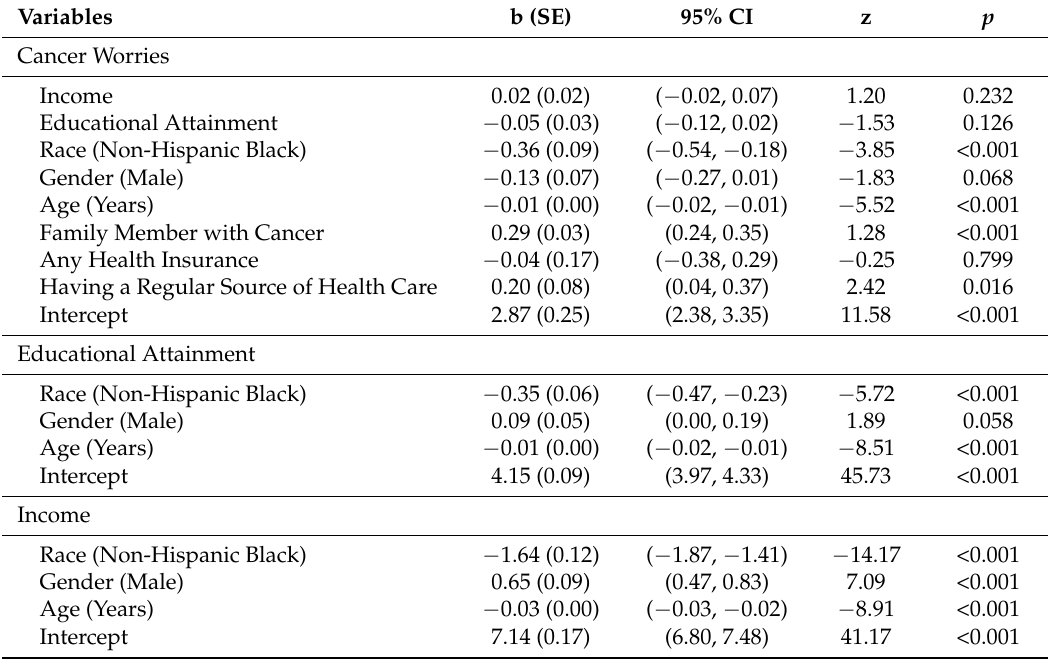
Table 5. The associations between race, socioeconomic status (SES; educational and income), and cancer worries in a nationally representative sample of American